Question: Identify the chart type used in this figure.
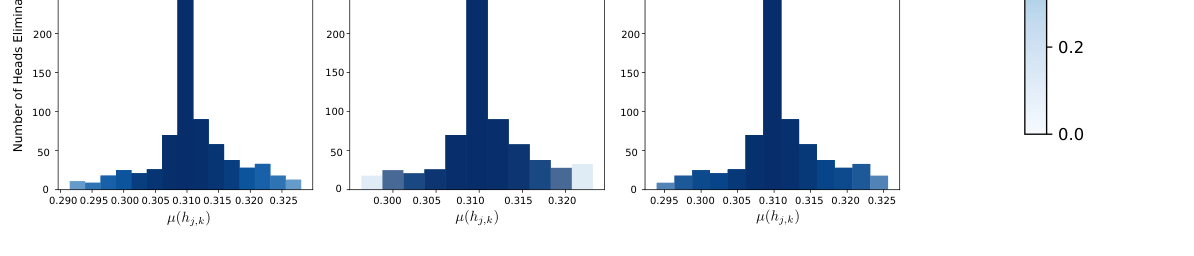
Answer: histogram